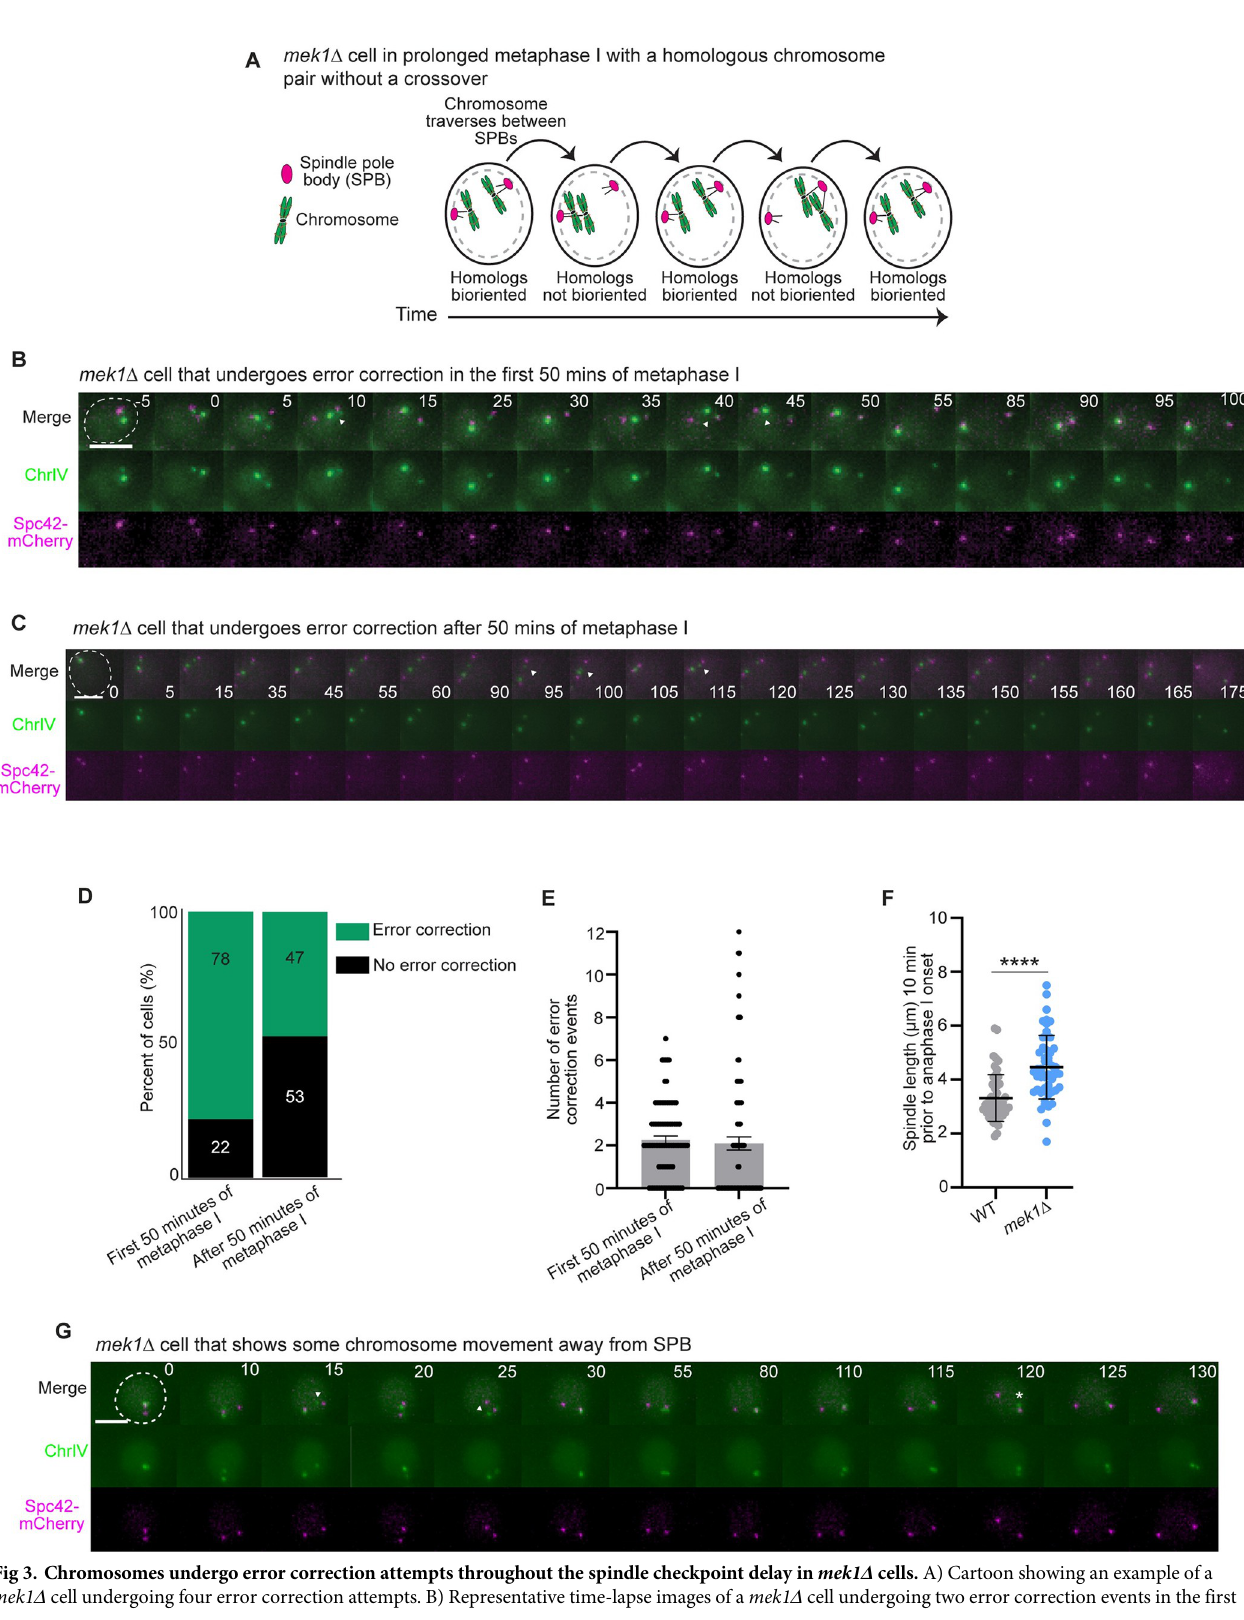
Fig 3. Chromosomes undergo error correction attempts throughout the spindle checkpoint delay in mek1 Δ cells. A) Cartoon showing an example of a mek1 Δ cell undergoing four error correction attempts. B) Representative time-lapse images of a mek1 Δ cell undergoing two error correction events in the